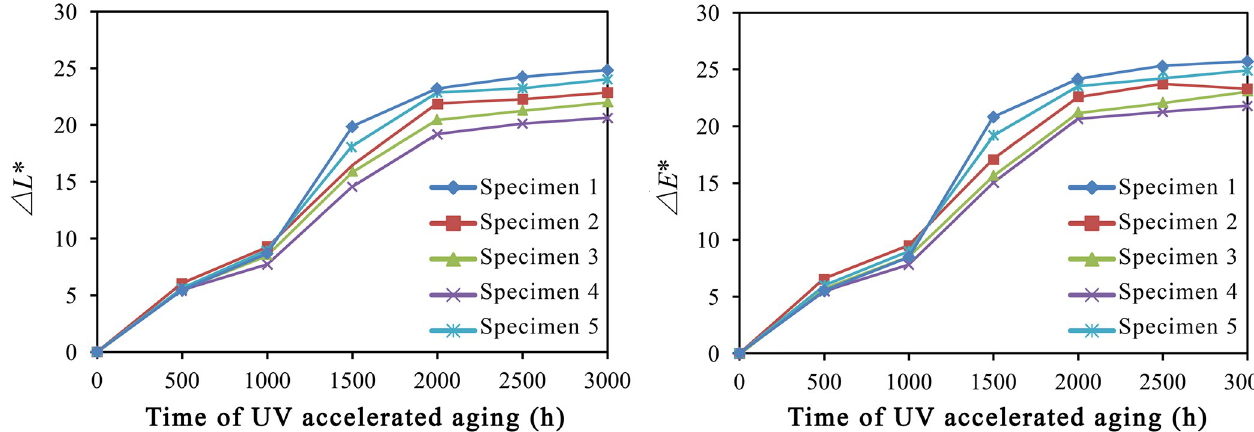
Fig 6. Surface chromaticity changes after UV-accelerated aging. Δ L � - Luminosity value; Δ E � - Degree of discoloration.